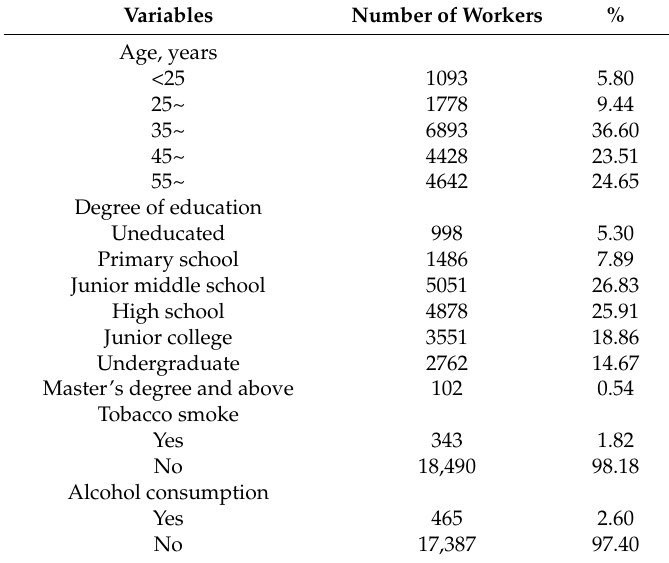
Table 2. Demographic Characteristics of Study Subjects in the Jinchang Cohort Study ( n = 18,834). Variables Number of Workers